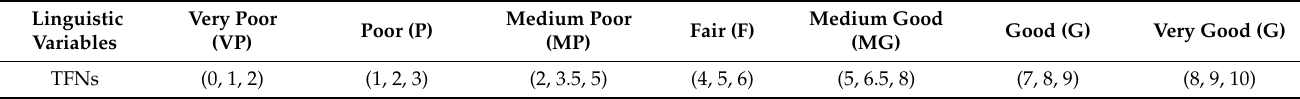
Table 6. Linguistic variables for rating failure